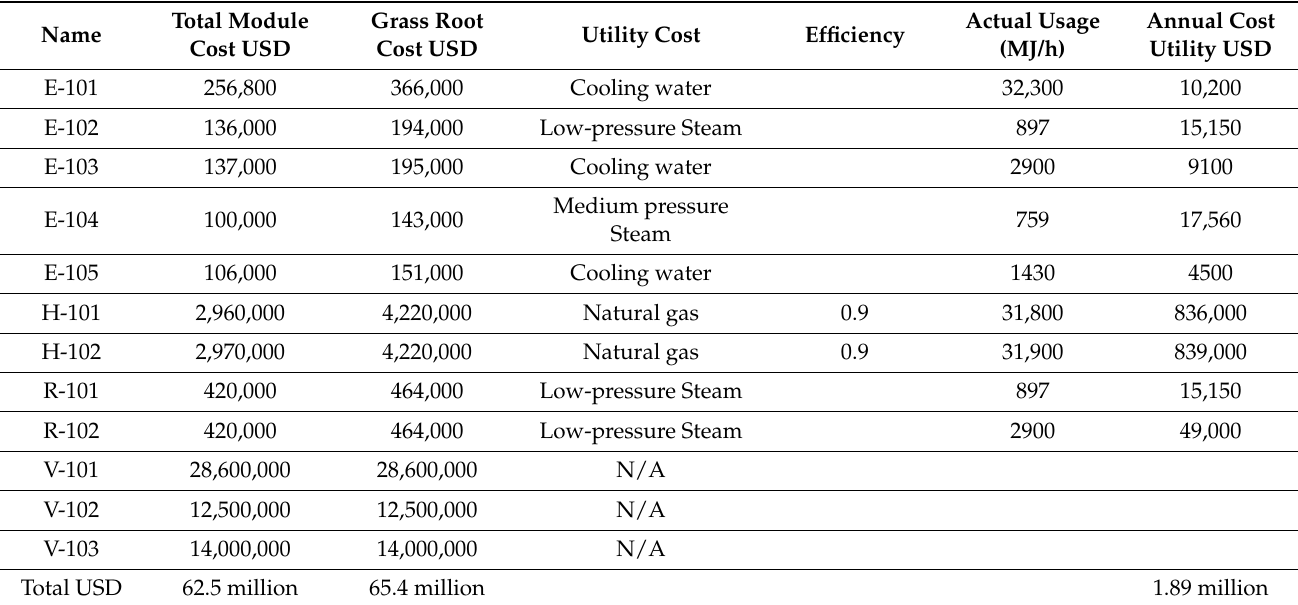
Table 10. Utility summary of the Claus process.